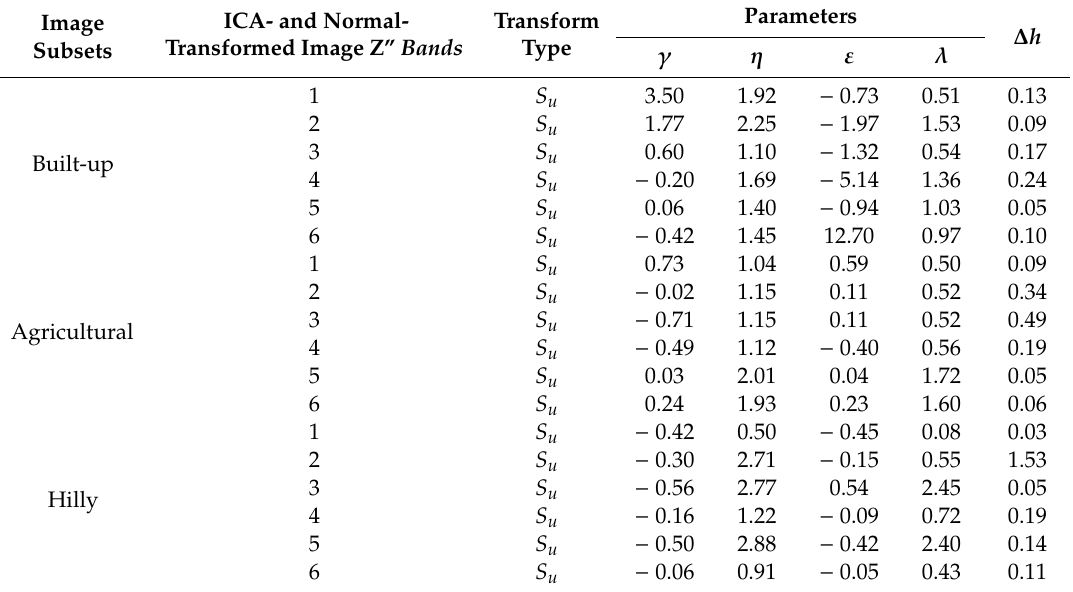
Table 1. Normal transform parameters (see Equation (6)) and entropy di ff erence values for the three image